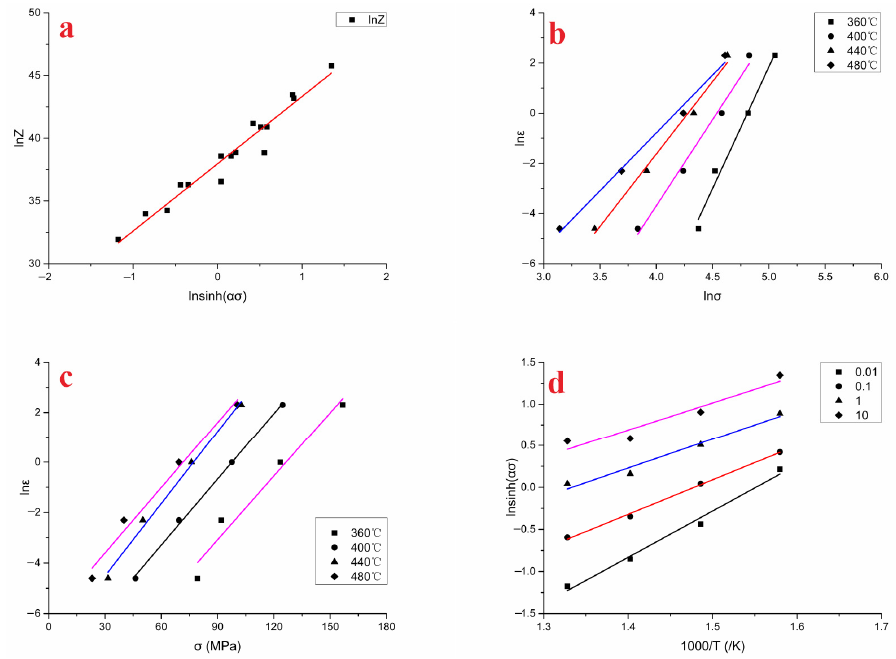
. . ε — ln σ ; ( c ) ln ε — σ ; ( d ) ln [ sinh ( ασ )] — 1000 / T